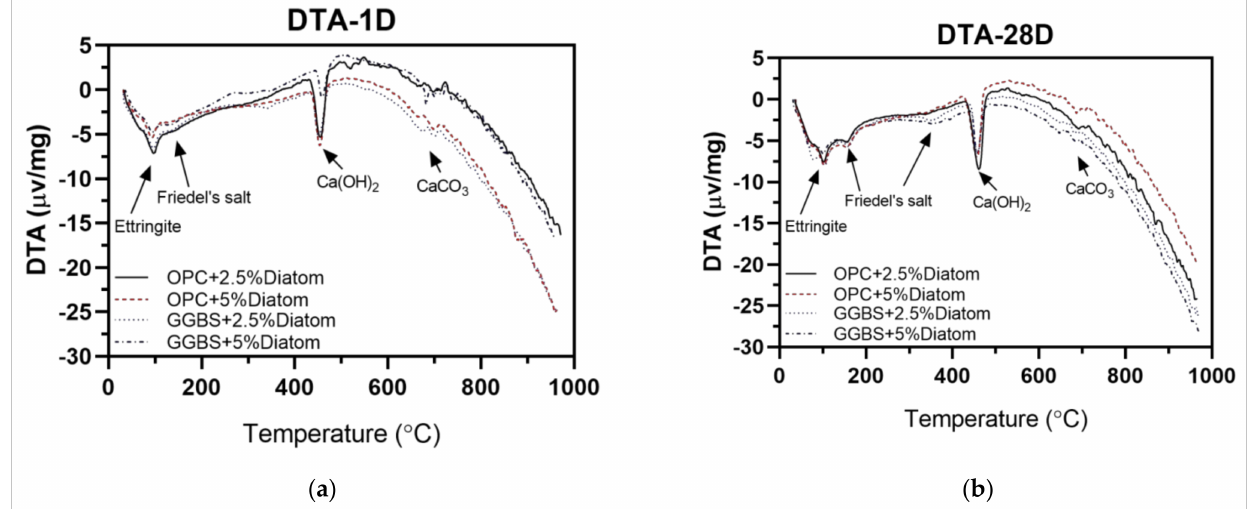
Figure 5. Effect of Diatom on the DTA results of cement paste, ( a ) 1D, ( b ) 28